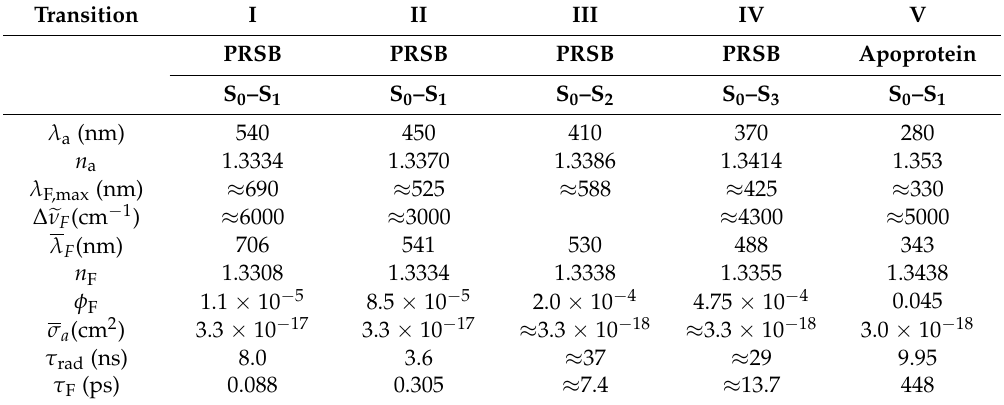
Table 1. Spectroscopic parameters of emitting parts of fresh thawed CaRh in pH 7.3 HEPES/MOPS buffer.